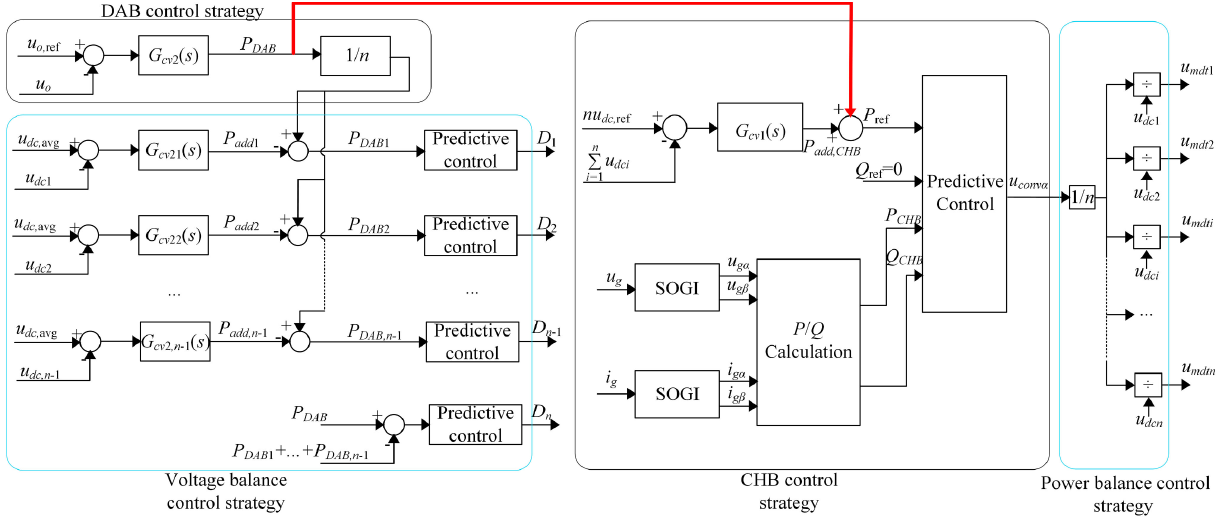
Figure 16. Overall MPC-based control scheme proposed in